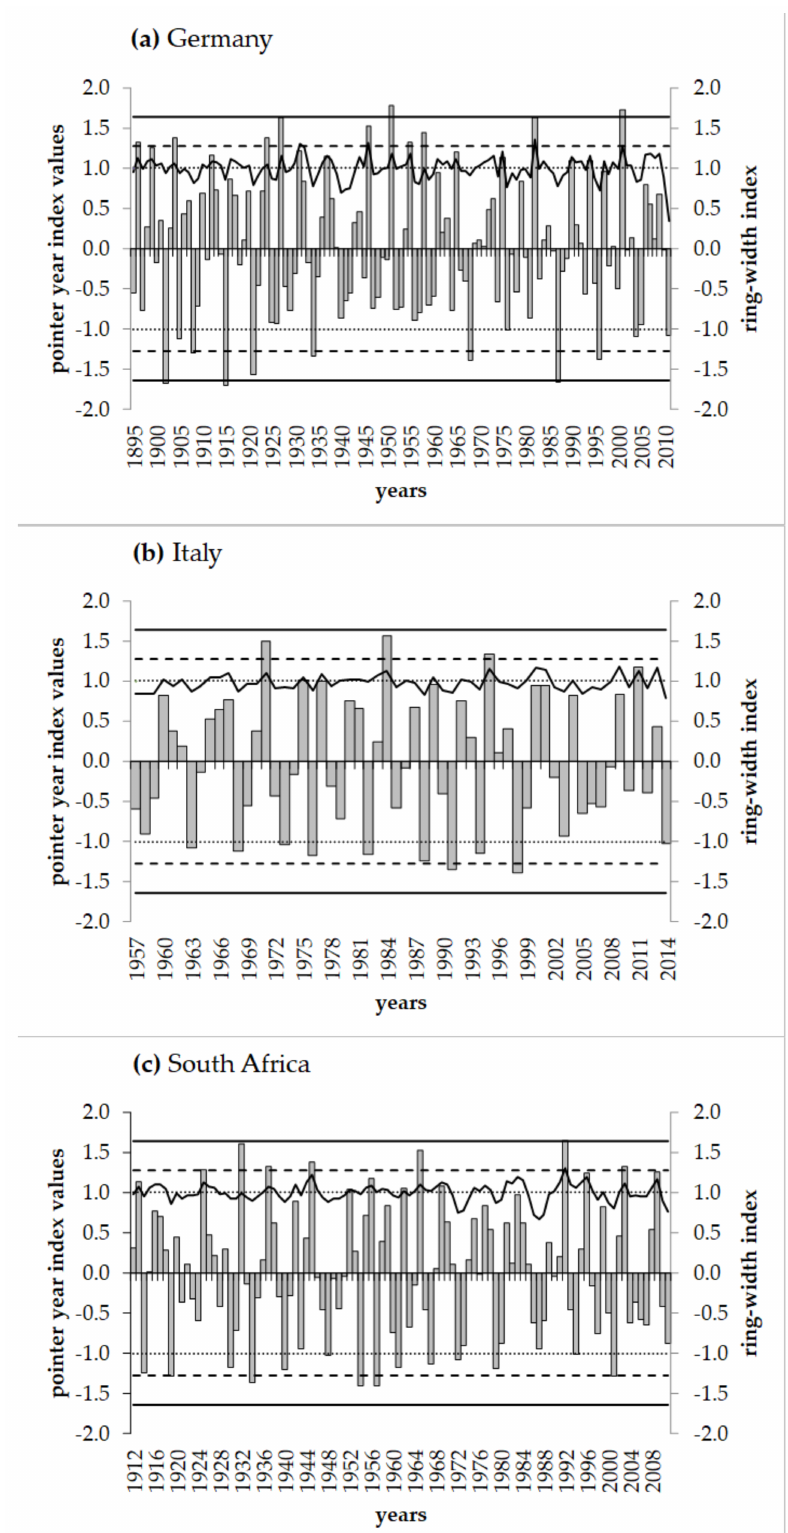
Figure 7. Study site-specific pointer years for the periods 1895–2010 Germany ( a ), 1957–2014 Italy ( b ), and 1912–2010 South Africa ( c ). Timespans are according to the chronologies minimum sample depth of 10. Horizontal lines indicate the threshold Cropper values (C): weak for (C) > +1.000/ − 1.000, strong for (C) > +1.280/ − 1.280, and extreme for (C) +1.645/ − 1.645 (Neuwirth et al. 2007 [56]). The black graphs represent the ring-width index